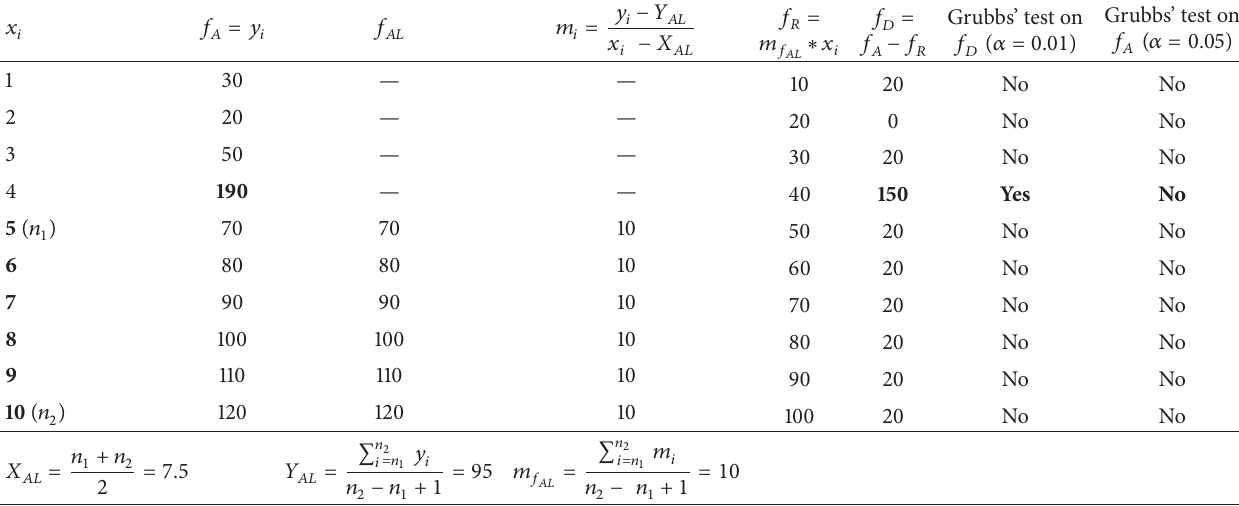
Table 4: Data set 2 ( 𝑛 = 10 ): maximum element of the data set is the outlier, but it is not the first or the last element. With new transformation technique, Grubbs’ test on 𝑓 𝐷 is capable of identifying the outlier with significance level of 0.01. However, Grubbs’ test on 𝑓 𝐴 is capable of identifying the outlier with even significance level of 0.05.